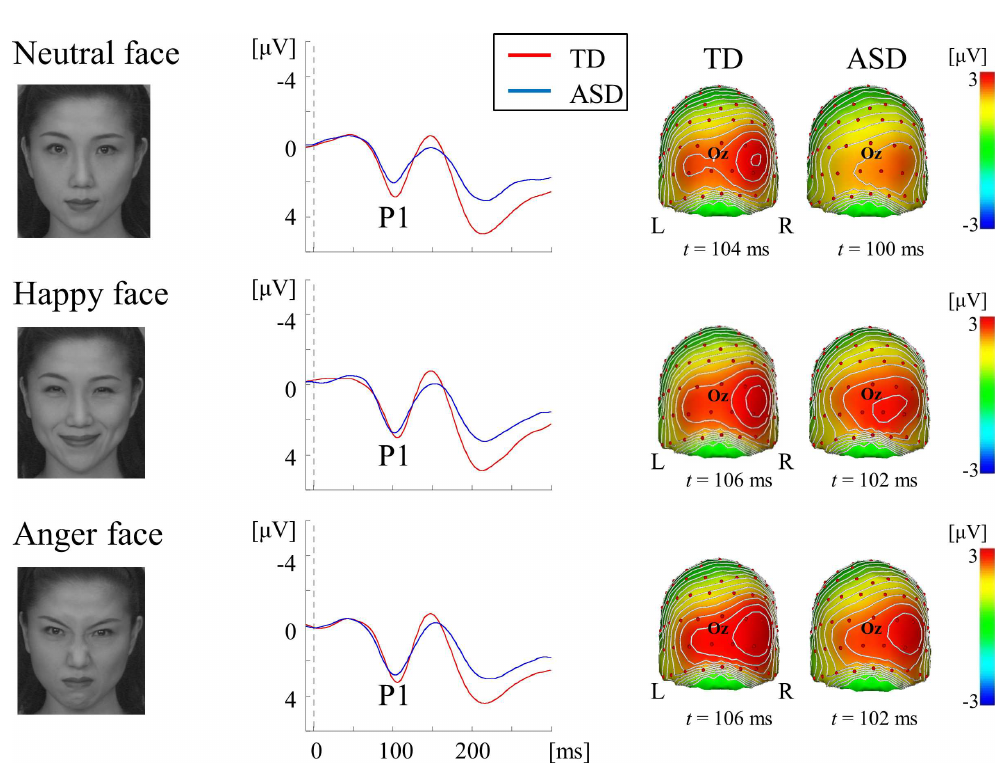
Fig 2. VEPs for face stimuli at the right occipital ROI in each group. Grand-averaged waveforms illustrate that P1 was evoked as a major componentfor all facial expressions. Scalp topographyshows that P1 was distributed over the bilateraloccipital area with right